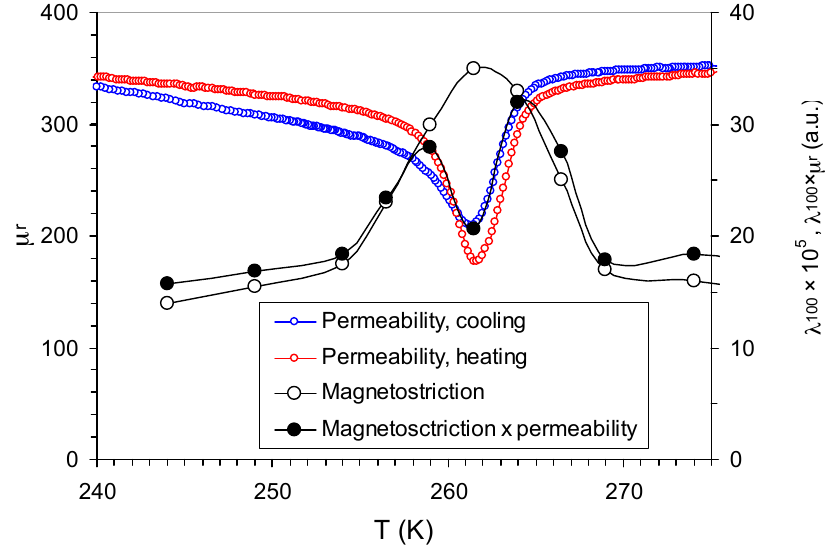
Figure 3. Temperature spectra of reversible permeability µ r , saturation magnetostriction λ 100 (values are taken from Figure 1b of Ref. [6]) and of their product λ 100 × µ r , which is proportional to the microeddy relaxation strength ∆ µ